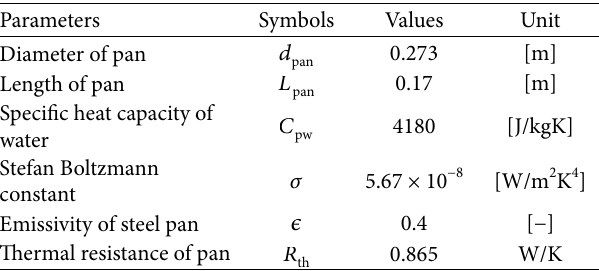
Table 4: Dimensions and values required during water boiling sim- ulation [18].